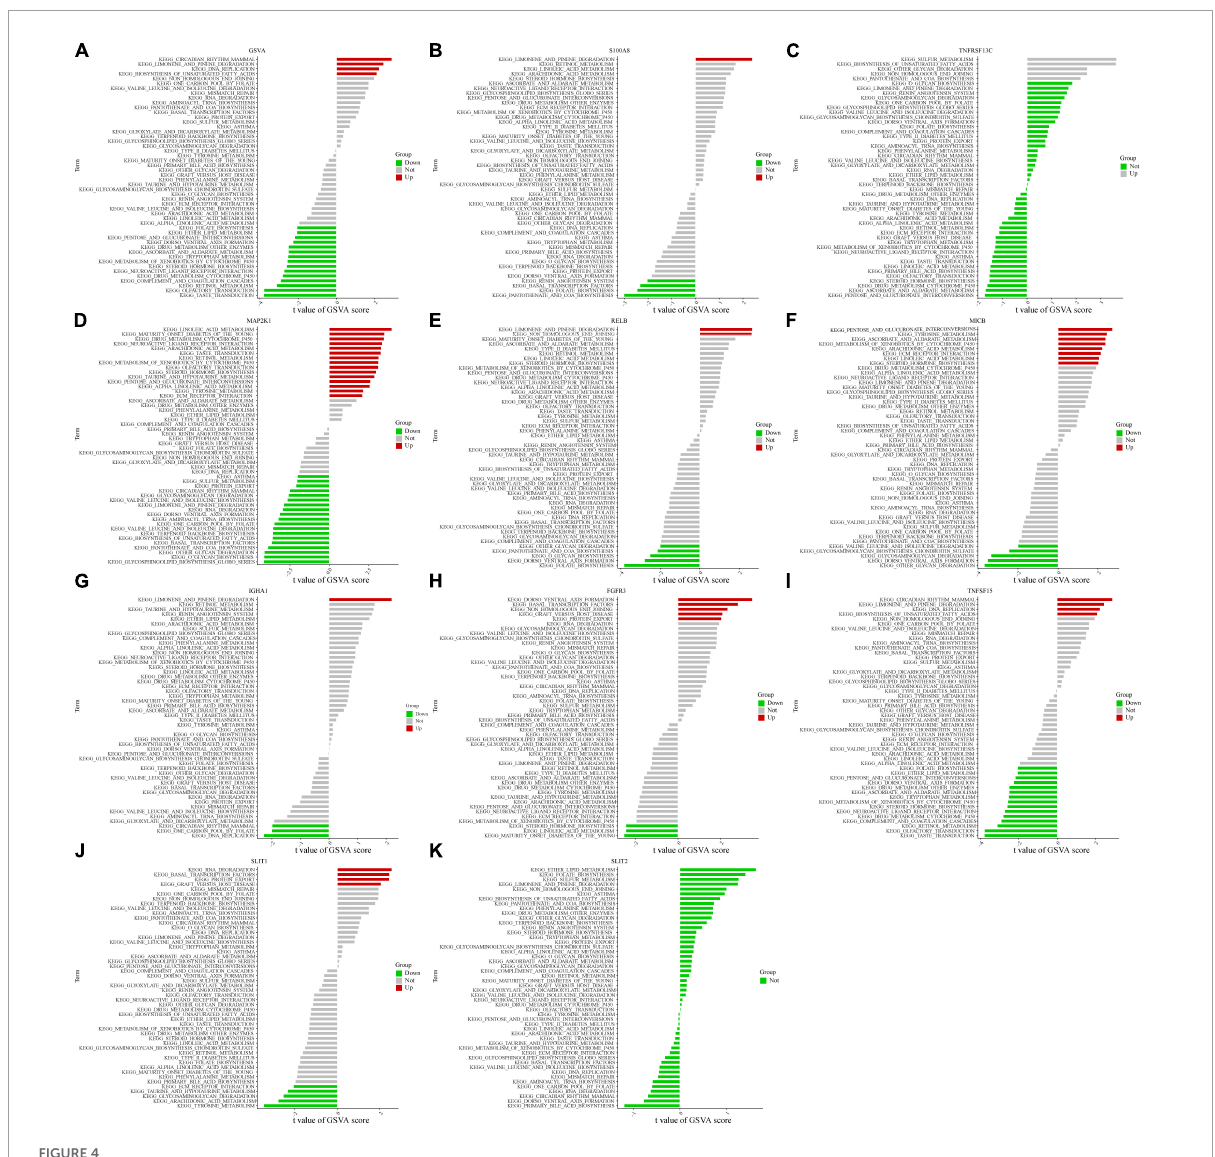
FIGURE4 Single-gene GSVA. (A) OFGs model of GSVA results. (B–K) Expression levels of single marker genes in the